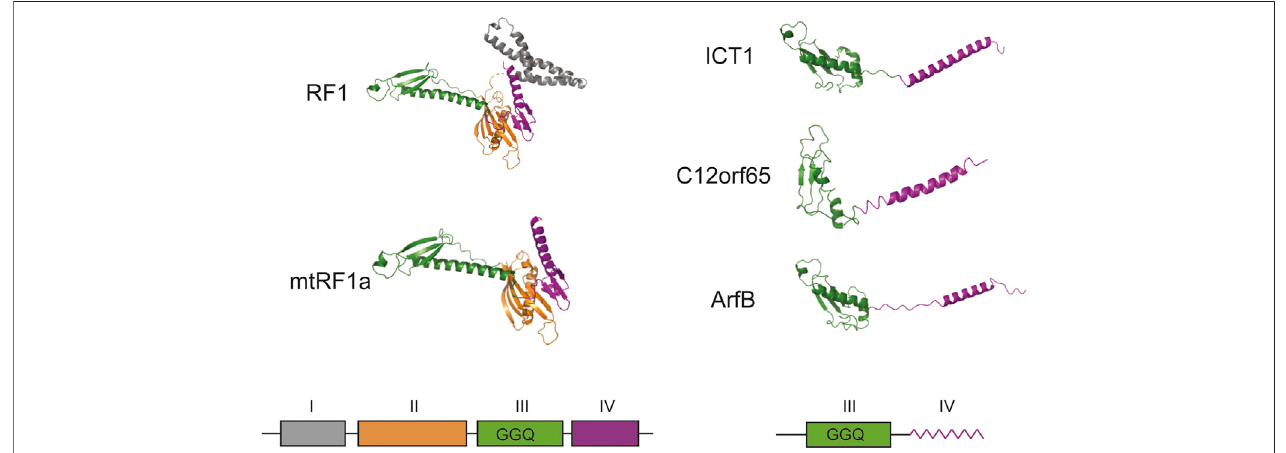
FIGURE 1 | Schematic structural overview of homologous prokaryotic and mammalian mitochondrial translation termination and ribosome rescue factors. The corresponding schematic representation of the domain organization is given below. All structures were adapted from PDB: Escherichia coli RF1 (6DNC), Homo sapiens mtRF1a (7NQH), H. sapiens ICT1 (7NQL), H. sapiens C12orf65(7A5H), E. coli ArfB (6YSS). No high-resolution structure is available for mammalian mtRF1, but it should be close to mtRF1a according to sequence similarity. I – domain of unknown function (grey), II – structural domain (orange), III – peptidyl-tRNA-hydrolase domain (green), IV – codon recognition domain (purple). In ICT1, C12orf65 and ArfB domain IV is schematically shown as a zigzag line to highlight its alpha-helical folding. The density ofdomain Iisabsentonthe fi gurebecauseitwasnotresolved inPDB: 7NQH. GGQdesignatesthethree essentialcatalytic residuesofpeptidyl-tRNA-hydrolase domain. All structures are given as cartoon